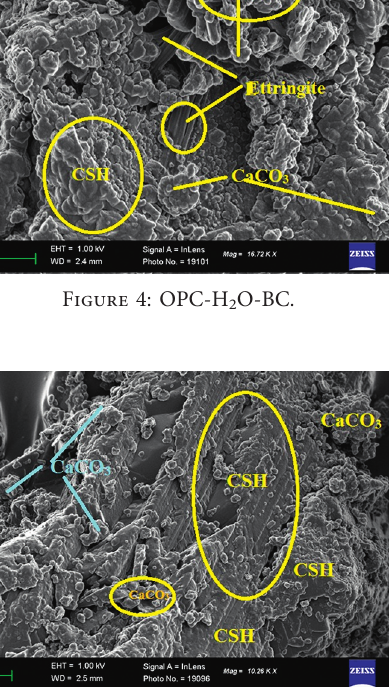
Figure 5: OPC-BC-H